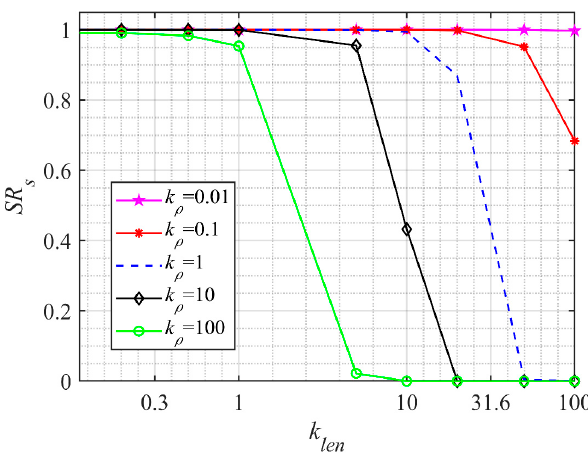
Figure 4. SR of density proxy model changing with control parameters.